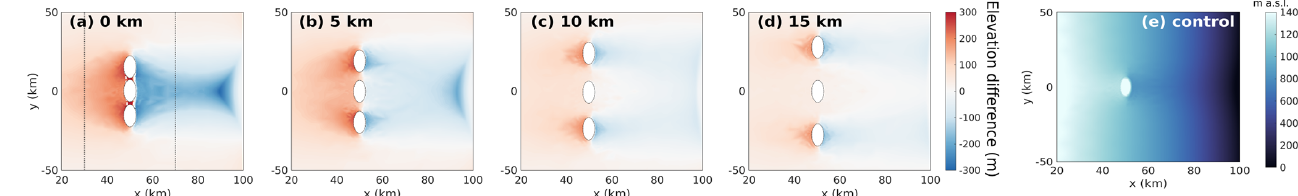
Figure 7. (a–d) Difference in surface elevation (m) between each three-nunatak thw experiment of varying glacier widths (0, 5, 10, 15km, respectively) with respect to the one-nunatak thw control run (shown in panel e for reference), after 20kyr of simulation. White ellipses delineate the nunataks in each experiment, and dashed white lines in panel (a) enclose the region between them where bedrock is exposed during this experiment. Dotted black lines in panel (a) illustrate the position of the transects shown in Fig. 8. From this figure it is clear that a larger obstacle or a narrow glacier can increase the differential response up- and downstream of the nunataks when compared to the single-nunatak case.